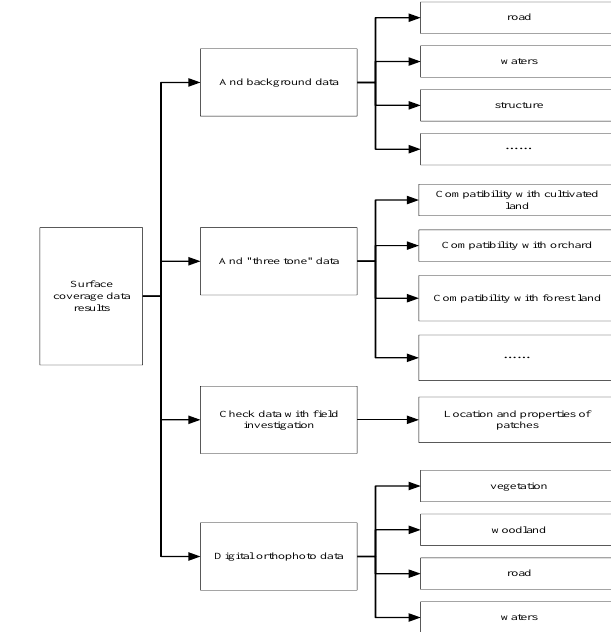
Figure 2. Consistency requirements of surface coverage